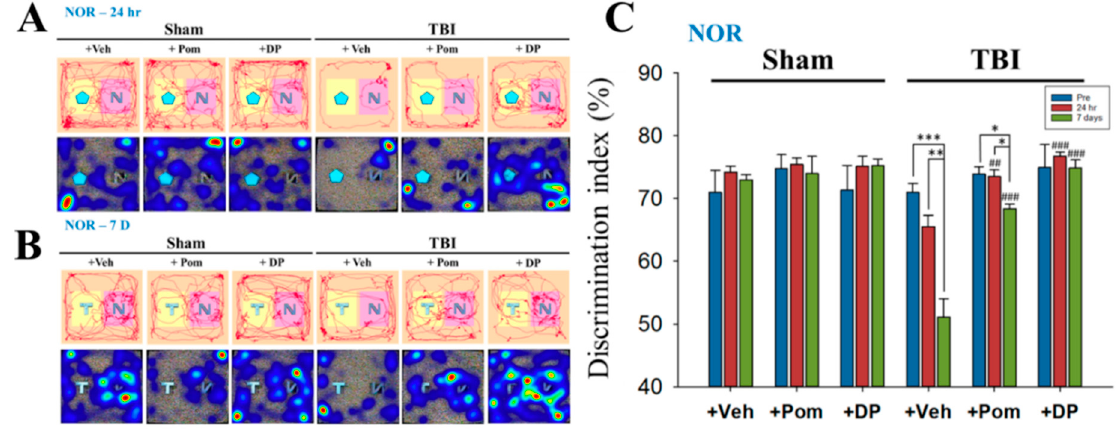
Figure 4. DP completely restored the TBI-induced short-term memory loss at 7D, whereas Pom only partially improved it when compared to pre-TBI levels. Representative traces and heatmaps of rat movements during the performance of NOR at 24 h ( A ) and 7 days ( B ) after a TBI. On the heatmaps, the place where the rat stayed longer is shown in red. ( C ) The discrimination index at different time points in the Sham + Veh, Sham + Pom, Sham + DP, TBI + Veh, TBI + Pom and TBI + DP groups. Data are expressed as the mean ± SEM. * p < 0.05, ** p < 0.01, *** p < 0.001 versus different time points in the same group; ## p < 0.01, ### p < 0.001 versus TBI + Veh group at the same time point ( n = 5 in each group). Statistical differences were analyzed using one-way ANOVA, followed by Tukey’s post hoc comparisons.